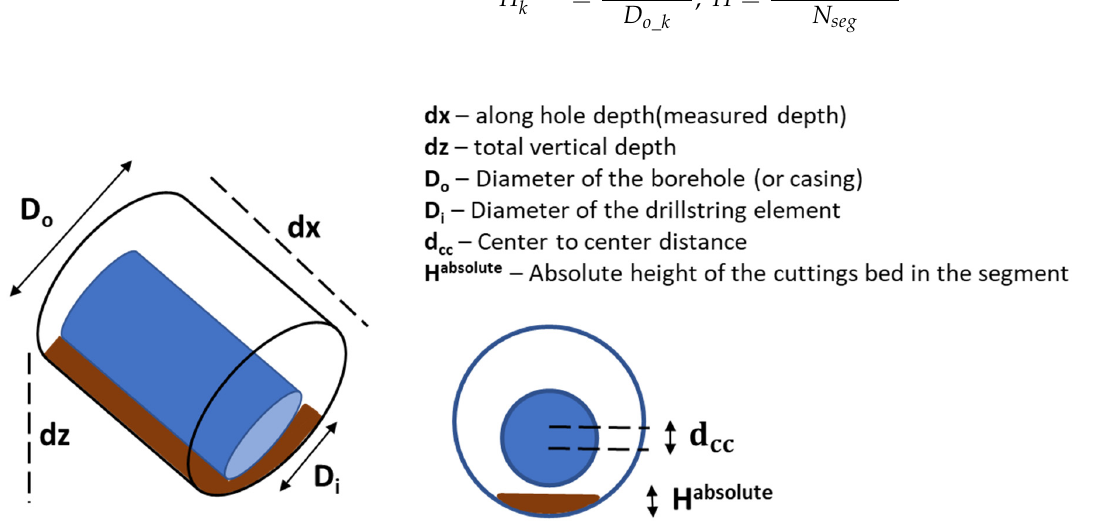
Figure 5. Absolute cuttings bed height for a single control volume element.